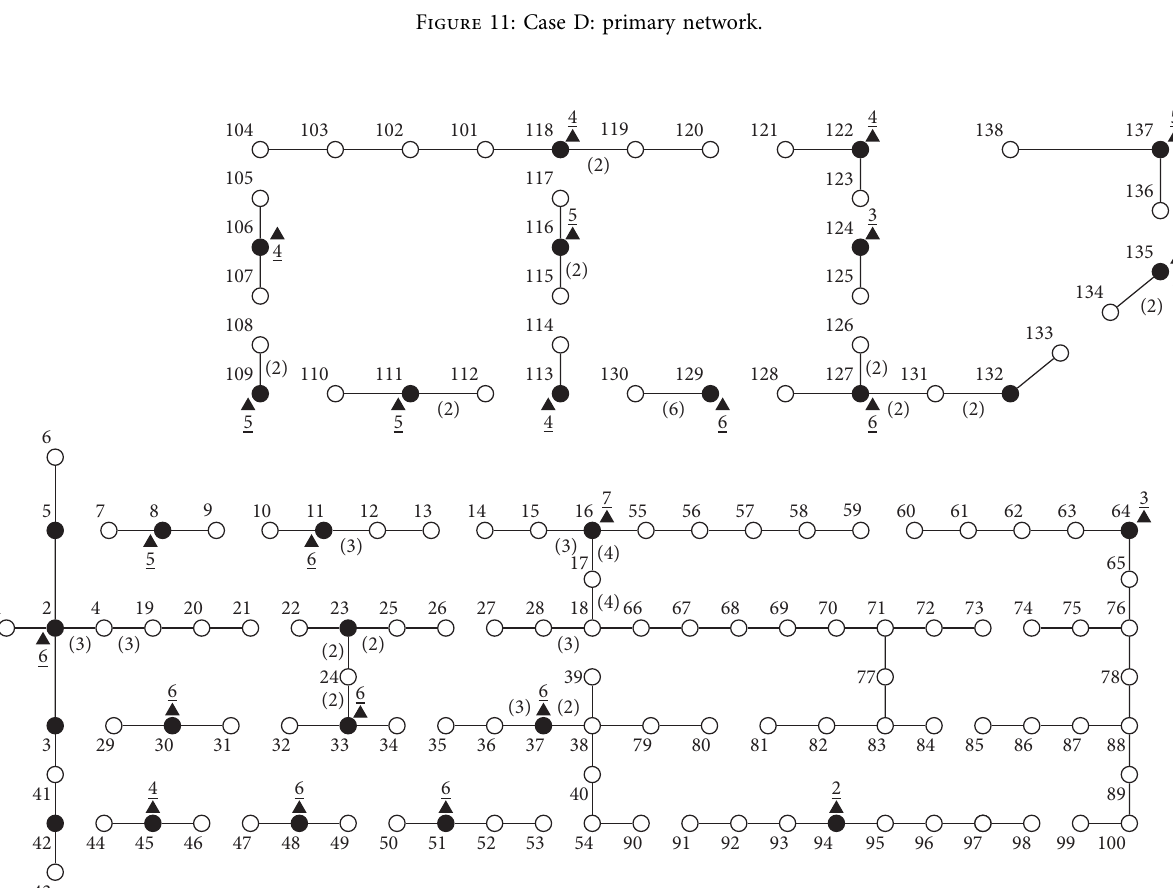
Figure 12: Case D: secondary